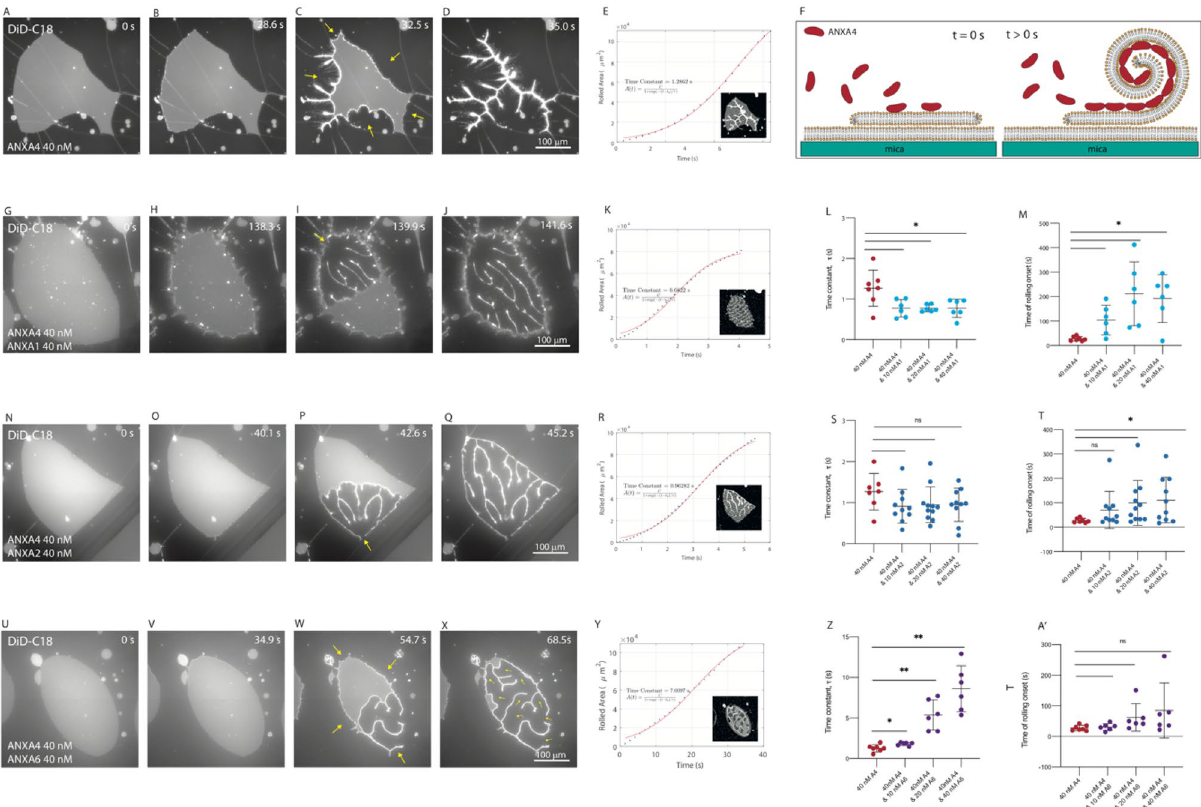
Figure 1. Membrane patch rolling induced by mixtures of ANXA4 and the crosslinking annexins. Response of non-vesicular membrane patches with open edges (DOPC/DOPS, 9:1 molar ratio) to exposure to annexins: 40 nM ANXA4 ( A – D ) induced complete, multidirectional roll up, initiated from points on the free edges (arrows, C ). Quantification of the incremental area reduction between image frames is shown graphically ( E ) where alternating dark and light grey bands show area reduction during rolling (inset, E ). Plotted as cumulative rolled area (blue circles, E ) the rolling time constant, τ, was derived from a fit to a logistic function (red line, E ). Schematic of ANXA4 induced membrane rolling of a membrane patch with open edges resting on a primary supported membrane ( F ); 40 nM ANXA4 and 40 nM ANXA1 ( G – J ) induced complete, unidirectional roll up from a single point (arrow, H ) after patch edges were bound to the supporting membrane, with membrane stretching from edges causing corrugations ( H – J ). 40 nM ANXA4 and 40 nM ANXA2 ( N – Q ) induced complete, unidirectional roll up from a single point (arrow, O ) after patch edges were bound to the supporting membrane. 40 nM ANXA4 and 40 nM ANXA6 ( U – X ). Multidirectional rolling, initiated from points on the free edge (arrows, V ), followed by binding of rolled patch edges to the supporting membrane and unidirectional rolling continued from a single point for each rolling segment ( W ). Quantification of the incremental area reduction between image frames is shown graphically (inset) for mixtures of 40 nM ANXA4 with 40 nM ANXA1 ( K ), ANXA2 ( R ) and ANXA6 ( Y ). Rolling time constants for 40 nM ANXA4 and 10, 20 and 40 nM ANXA1 (light blue circles, L ) are significantly shorter (Welch’s t test, *P < 0.05) than 40 nM ANXA4 (red circles, L ). The time of rolling onset (light blue circles, M ) is significantly longer (*) than 40 nM ANXA4 (red circles, M); Rolling time constants for 40 nM ANXA4 and 10, 20 and 40 nM ANXA2 (dark blue circles, S) are similar to 40 nM ANXA4 (red circles, S). The time of rolling onset for 40 nM ANXA4 and 20 nM ANXA2 and 40 nM ANXA4 and 40 nM ANXA2 (dark blue circles, T) is significantly longer (*) than 40 nM ANXA4 (red circles, T), but not at 40 nM ANXA4 and 10 nM ANXA2 (dark blue circles, T); Rolling time constants for 40 nM ANXA4 and 10 nM ANXA6, 40 nM ANXA4 and 20 nM ANXA6 and ANXA4 and 20 nM ANXA6 (purple circles, Z) are significantly longer (*) than for 40 nM ANXA4 (red circles, Z). The time of rolling onset for 40 nM ANXA4 and 10, 20 and 40 nM ANXA6 (purple circles, A ′ ) was not significantly greater (*) than 40 nM ANXA4 (red circles, A ′ ). Images prepared using NIS elements, version 5.10 (https:// www. micro scope. healt hcare. nikon. com/ produ cts/ softw are/ nis- eleme in the scatter plots (Fig. 1L,S,Z) comparing ANXA4 rolling time (red circles) with the ANXA4/crosslinker mix- tures. The graphic inset in the plot (E) shows alternating dark and light grey bands corresponding to area reduc- tion during rolling (inset, E). Multidirectional rolling initiating from the points of rolling on the membrane patch edge (arrows, C). The process of membrane rolling by ANXA4 alone is shown schematically in Fig. 1F. Annexin mediated rolling, as first reported in Boye et al . 6 results when annexin monomers bind to the edge of the membrane patch and trimerize, inducing a spontaneous curvature, mediated by the curved disc shape of the